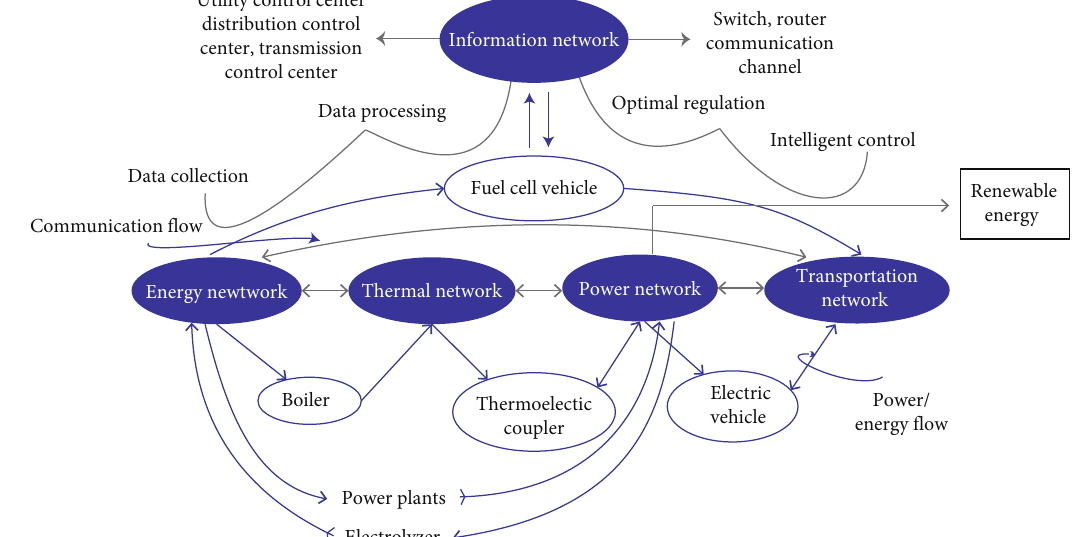
Figure 5: Structure of energy network. Redrawn from this source [52].